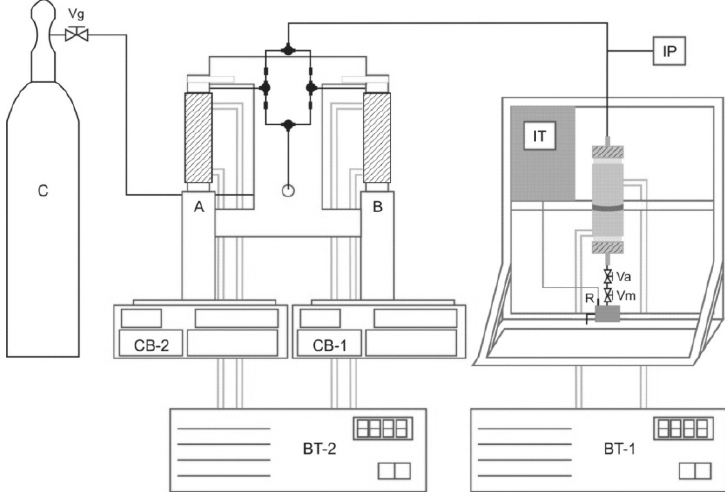
Figure 4. A and B –syringe pump; BT-1 and BT-2- thermostatic bath; C-CO2 cylinder; CB-1 and CB-2 –controller of syringe pump; IP –pressure indicator; IT –temperature indicator (thermal regulator); Va –needle valve; Vg –sphere valve; Vm –micrometering valve; R –collection reservoir.